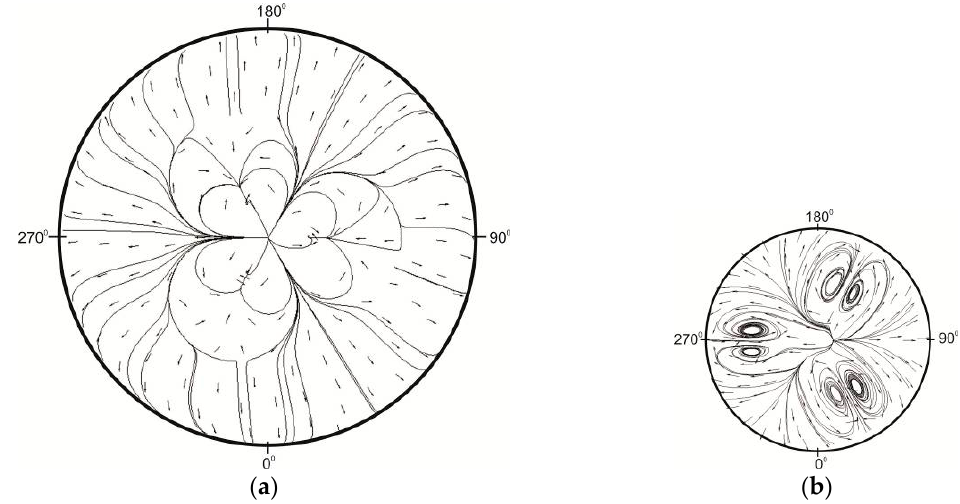
Figure 8. The trajectories of the melt flows in the bath horizontal sections, taking into account the heat-gravitational convection: ( a ) with Z = − 70 mm; (b) with Z = − 1320 mm.